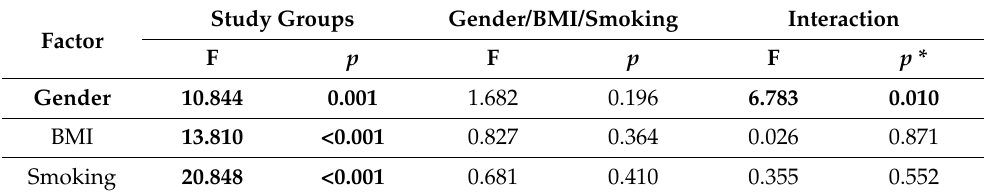
Table 4. Results of two-way ANOVA analyses on the methylation status of the IL-6 promoter. Study Groups Gender/BMI/Smoking Interaction Factor F